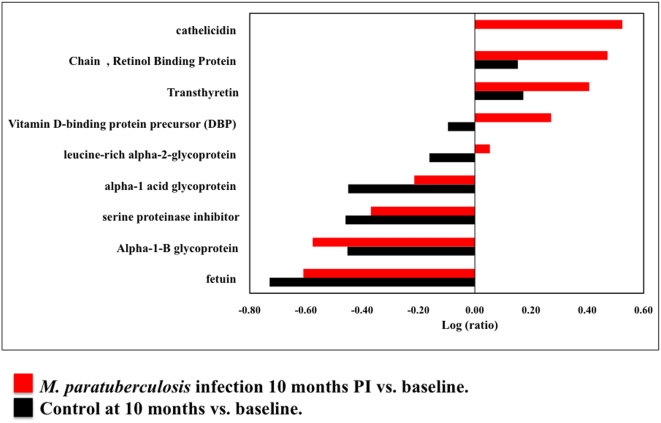
Biomarkers identified in advanced (10 months post infection) M. paratuberculosis infection.The bar graph represents log ratios of serum proteins (P-value<0.05, EF<2) identified in M. paratuberculosis infected (10 months PI) and control animals. Red bars represent log ratios of serum protein levels in M. paratuberculosis infected animals over time. The black bars represent the temporal trend in log ratios of the same proteins in control animals.